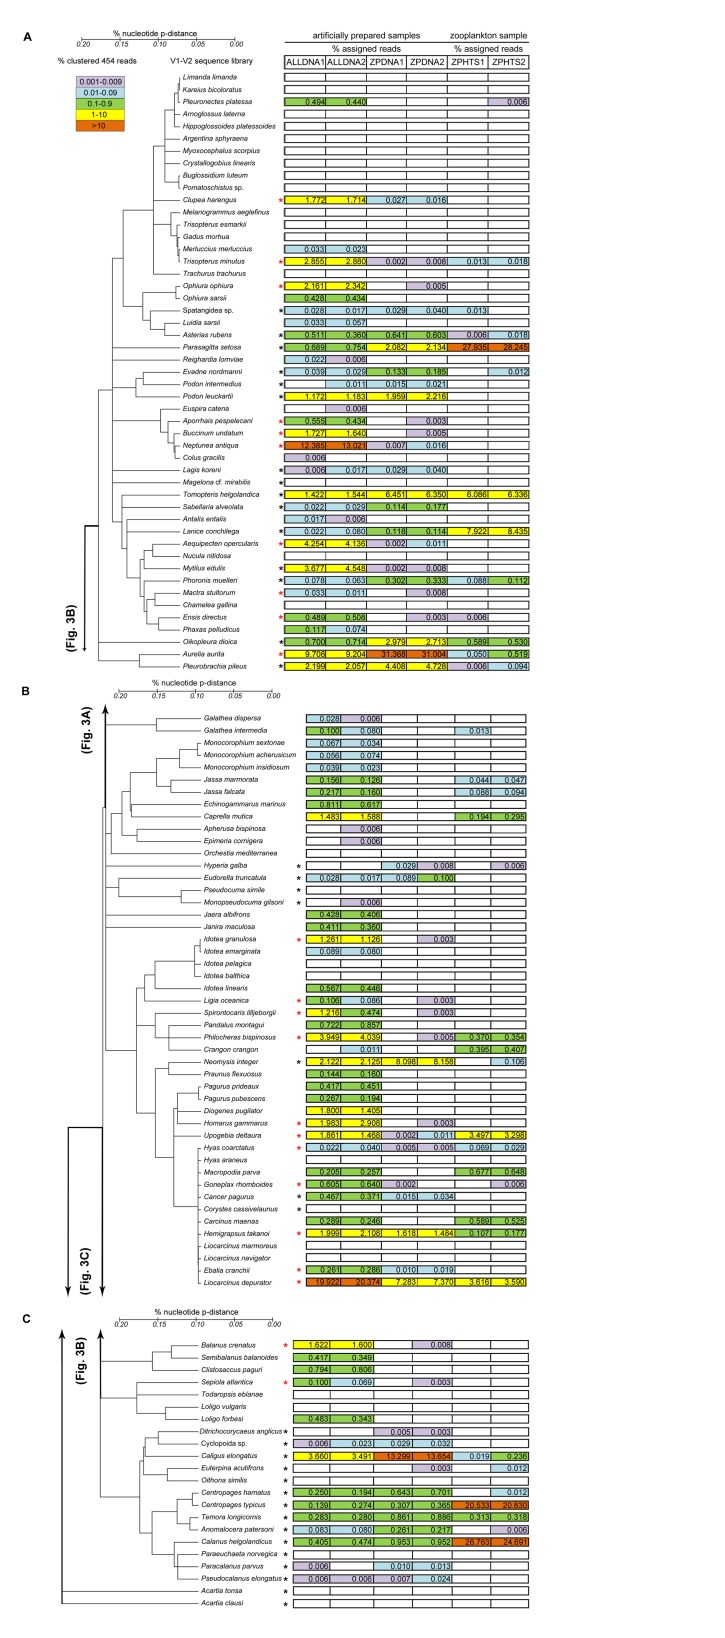
A) Species composition of North Sea metazoa from four aliquots of pooled, known DNA samples (ALLDNA, ZPDNA) and two aliquots of one field-collected zooplankton sample (ZPHTS), as assigned by 454 sequencing of the 18S rDNA: V1-V2 region.The tree, based on consensus sequences of the Sanger-generated reference library, was generated by the Neighbor-Joining algorithm / p-distance model. Clustering against the reference library was performed at 99% sequence similarity threshold using the program cd-hit-est-2d. Percentage of pyrosequencing reads for each species detected in each sample is shown by color-coded rectangles. Black asterisks denote species included in the artificially prepared ZPDNA sample. Red asterisks denote species not included, but detected in the ZPDNA sample. B) Figure 3A continued. C) Figure 3B continued.